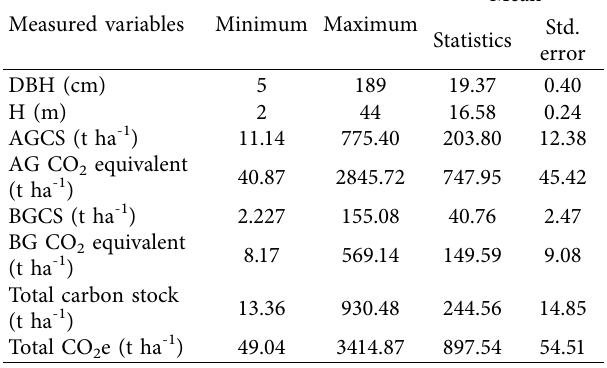
Table 1: Descriptive summary of AGCS, BGCS, and carbon di- oxide equivalent of the study